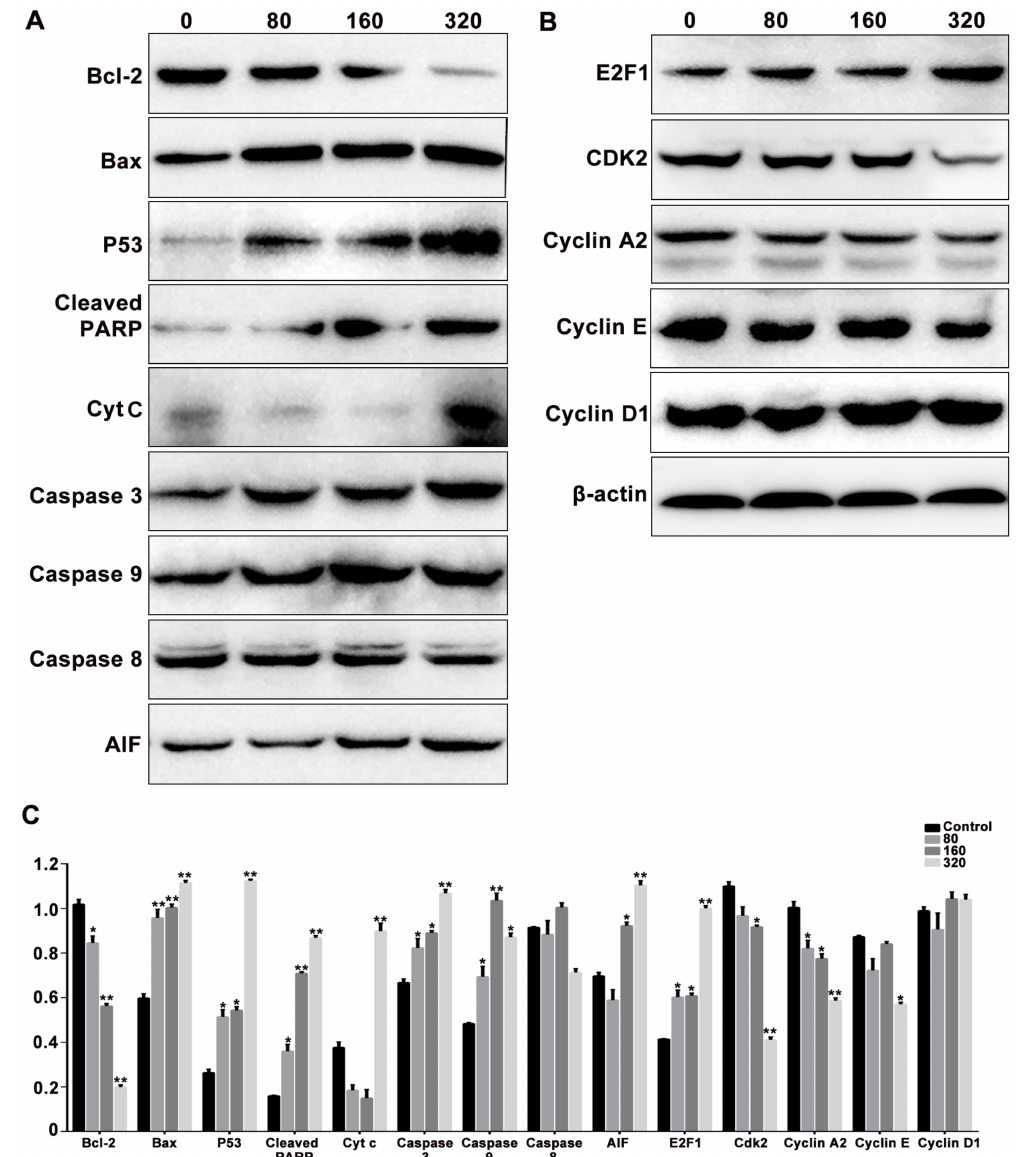
Figure 5. The effects of SPPH treatment on the expression levels of the apoptosis ( A ) and cell cycle ( B ) related proteins in SGC-7901 cells. Cells were treated with SPPH in different concentrations for 36 h, then applied to protein extraction and determination. β -actin was used as inner control. ( C ) Quantification of protein expression levels normalized to β -actin in the Western blotting analysis. Data are expressed as Mean ± SD of three independent experiments. * p < 0.05, ** p < 0.01 compared with the